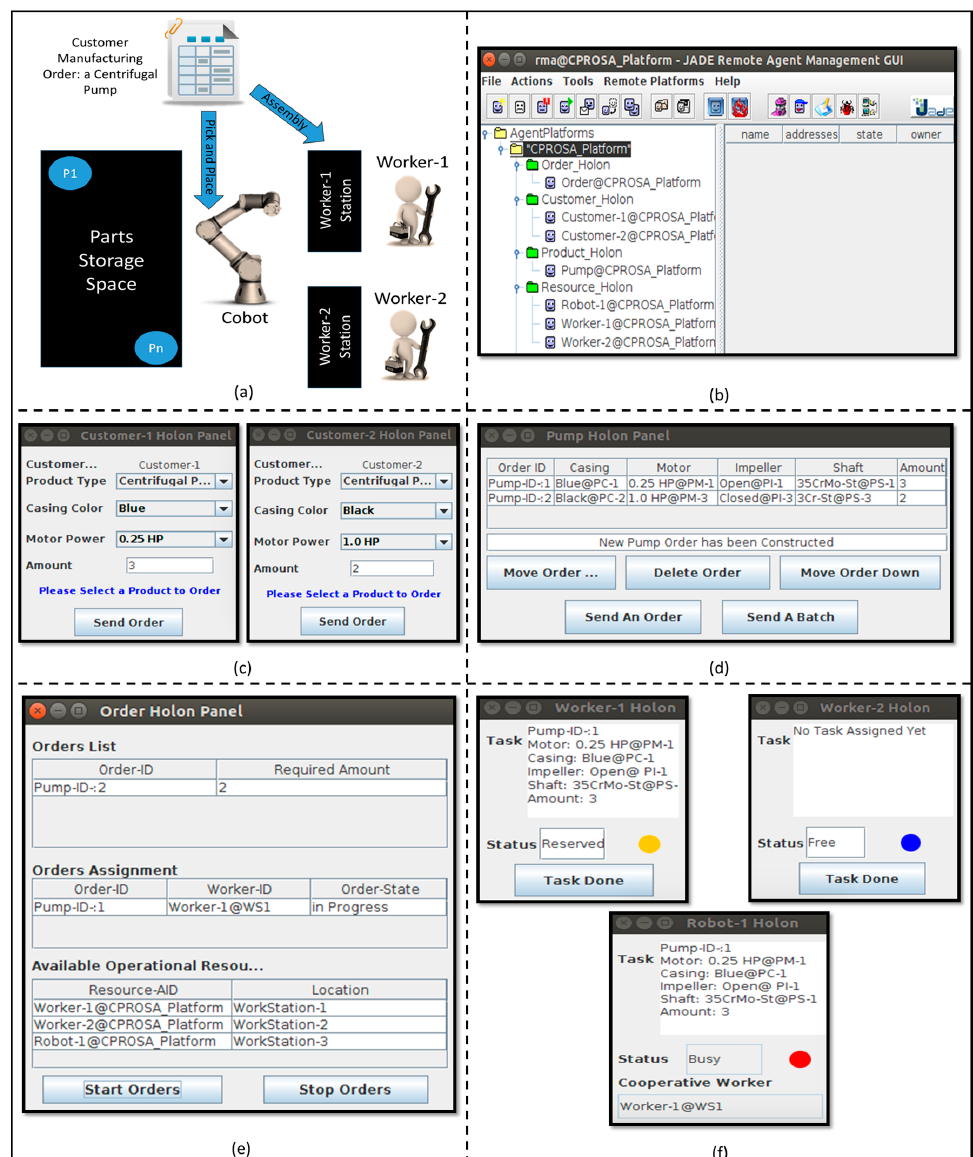
Figure 10. ( a ) Case-Study Schematic; (b) JADE Multi-Agent System; ( c ) Customer Holon Interface; ( d ) Products Holons Interface; ( e ) Order Holon Interface; ( f ) Operation Resources Holons Interface.